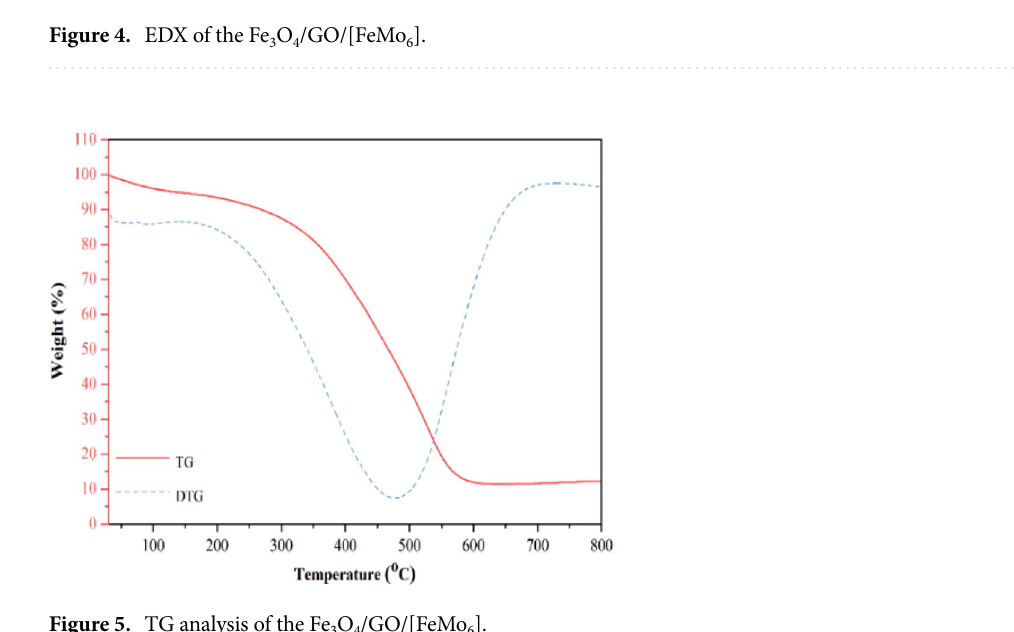
Figure 5. TG analysis of the Fe 3 O 4 /GO/[FeMo 6 ].